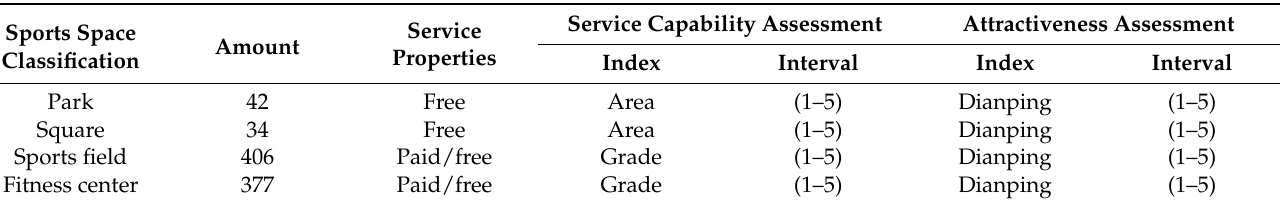
Table 1. Statistical information and evaluation criteria of influencing factors of sports